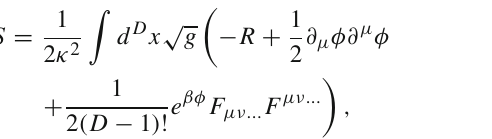
Fig. 3 A schematic cartoon of how Wormholes configurations may exist. On the left, the Wormhole begins and ends on the same asymptotic Universe, on the right, the Wormhole connects two asymptotic Universes. In the first case, an effective non-local description emerges within the same Universe, while in the latter, operators living on the two Universes couple through the Wormhole connecting